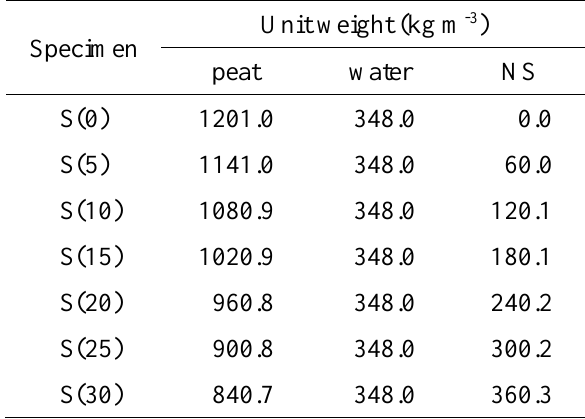
Table 4. Mixture